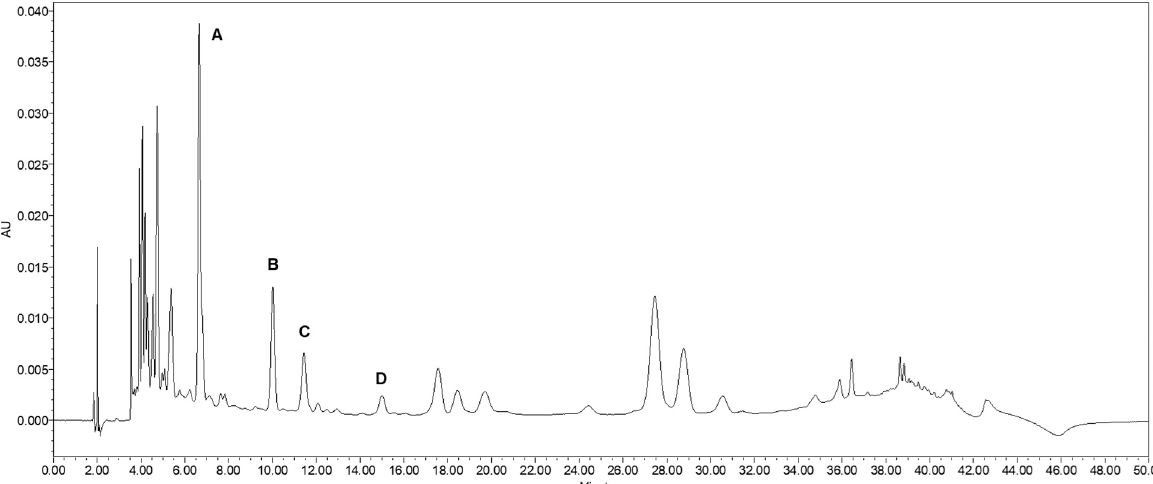
Figure 2. Representative PDA chromatogram of blueberry accession BNJ05-218-9 acquired at 366 nm. The characteristic peaks are labelled 1 through 4. (A) chlorogenic acid, (B) acetyl-caffeoylquinic isomer 1, (C) acetyl-caffeoylquinic isomer 2, (D) caffeoylarbutin.